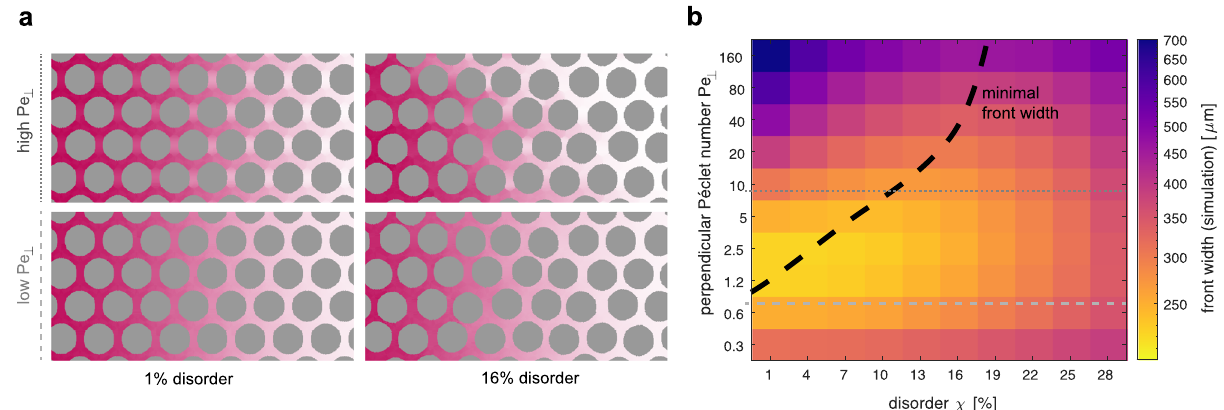
Fig. 4 | Non-monotonic dependence between dispersive front width and dis- order vanishes for small Péclet numbers. a Illustration on how dispersion dynamicsdependonadvectivetransport.Simulationsnapshotsvisualisinghowthe sharpeningofthedispersivefrontwidthreliesonthetransportmodeofadvection. A sharpening of the front width is only observed for large Péclet numbers. Porous media disorder has only little effect for low Péclet numbers, where transport in all pores is dominated by diffusion. b Evaluation of the effect of disorder and Péclet number on disperive front width. The effect of disorder and Péclet number on the